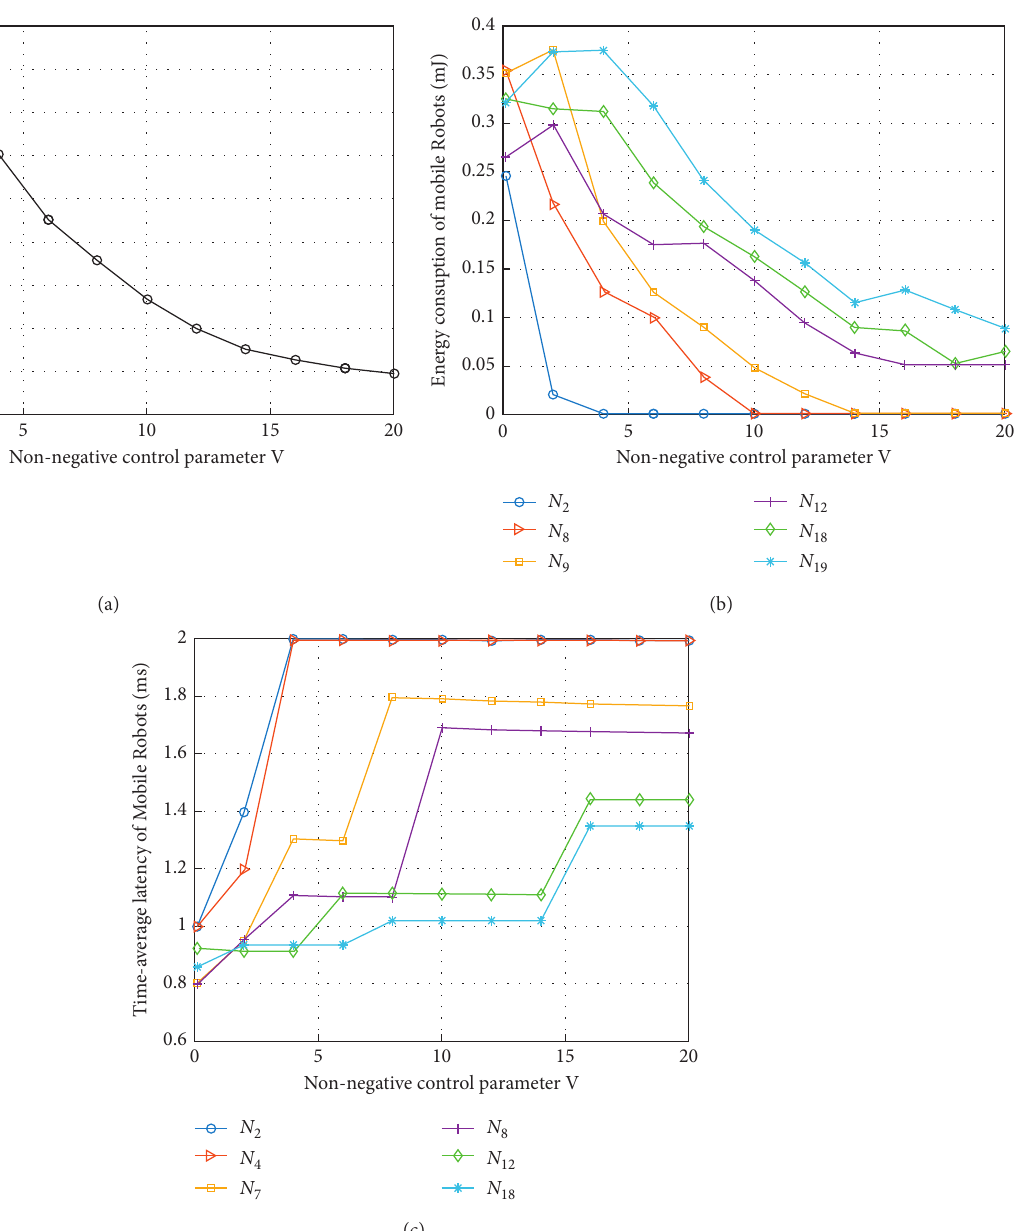
Figure 4: The effects of nonnegative controlparameter on mmWnetwork performance: (a) data rate; (b) energyconsumption; (c) average